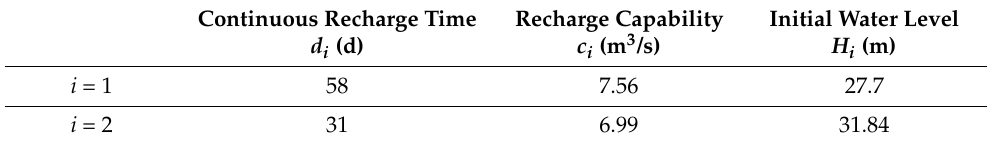
Table 8. Optimization scheme of single well